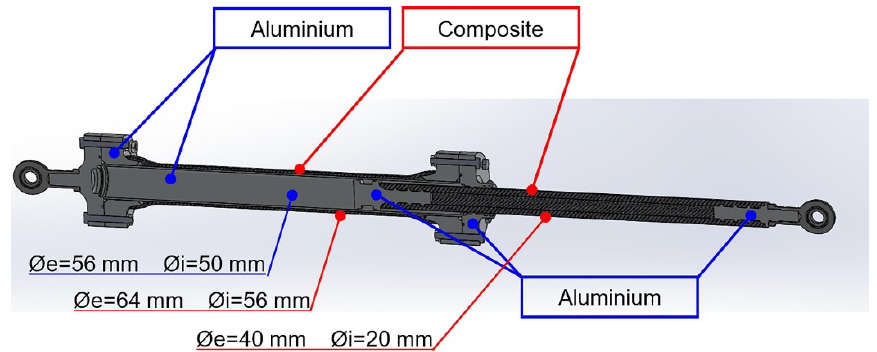
Figure 4. Geometrical model of an actuator designed by Solazzi [37].